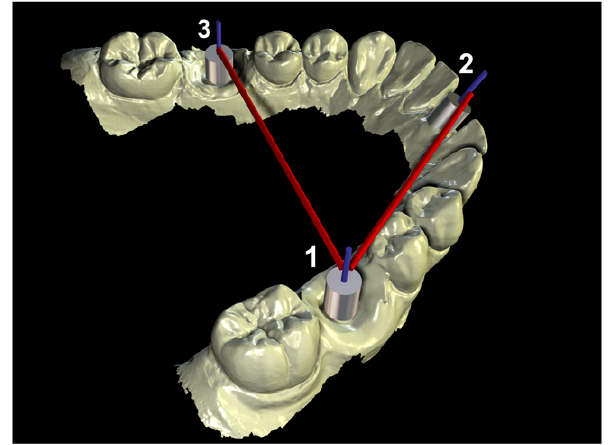
Figure 3. The technical principle of the Lava COS scanner. The Lava COS uses ‘‘active wavefront sampling’’ to calculate the 3D model of the teeth. For this the image reflected from the teeth is led through a lens system and eventually projected onto a sensor. If the image is in focus, the distance of the object coincides with the focal length of the lens. If the image is out of focus, the distance from the lens to the object can be calculated from the size of the blurred image through a simple mathematical formula.